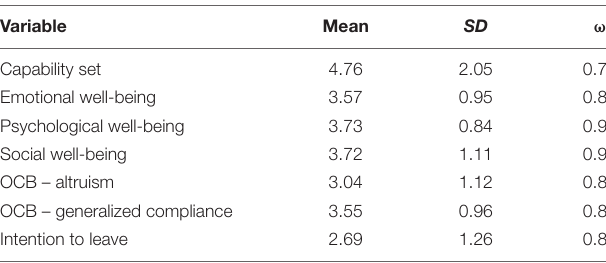
TABLE 3 | Descriptive statistics and internal consistency reliabilities of the dependent